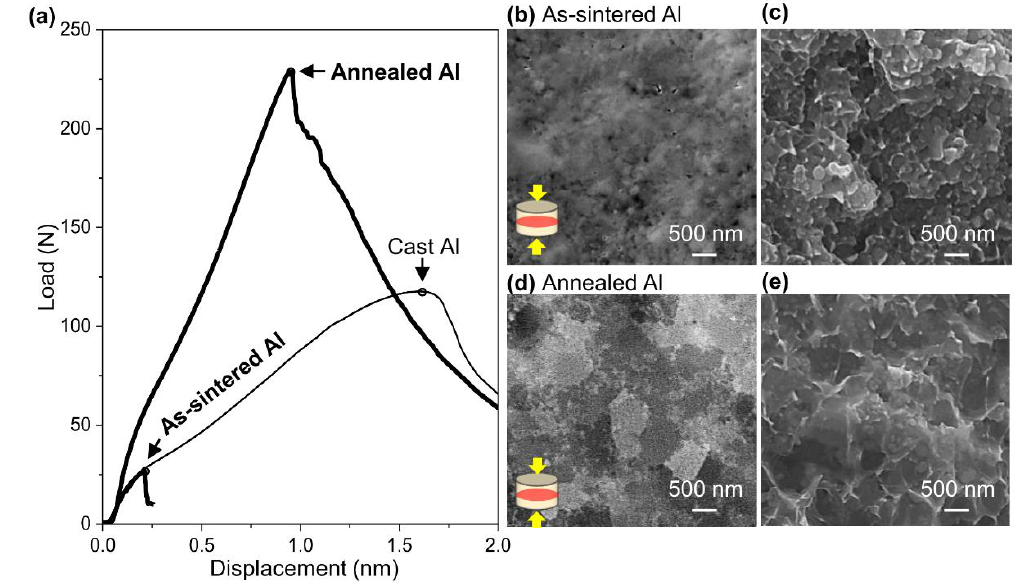
Figure 8. ( a ) Load-displacement curve of as-sintered, annealed Al compact and cast Al bulk used as reference (the small circles put on a curve at maximum load). FE-SEM images of ( b ) cross-section and ( c ) fracture surface after SP test of as-sintered Al, and ( d ) cross-section and ( e ) fracture surface after SP test of annealed Al.